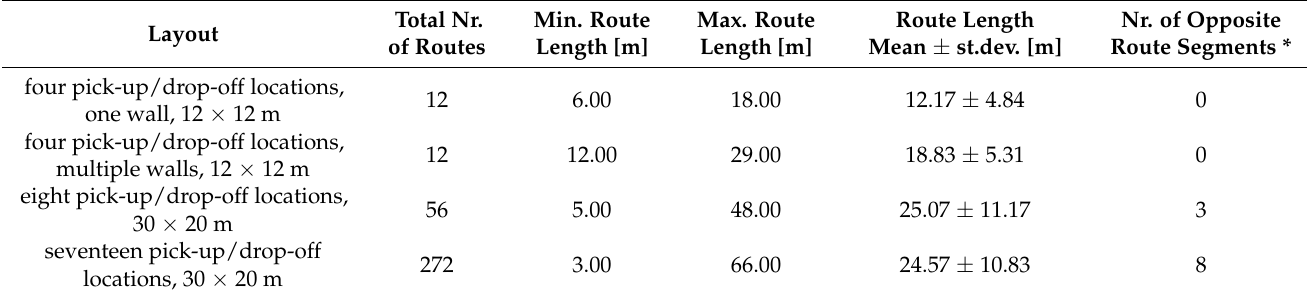
Table 6. Routes lengths, total number of routes and opposite route segments for different layouts.